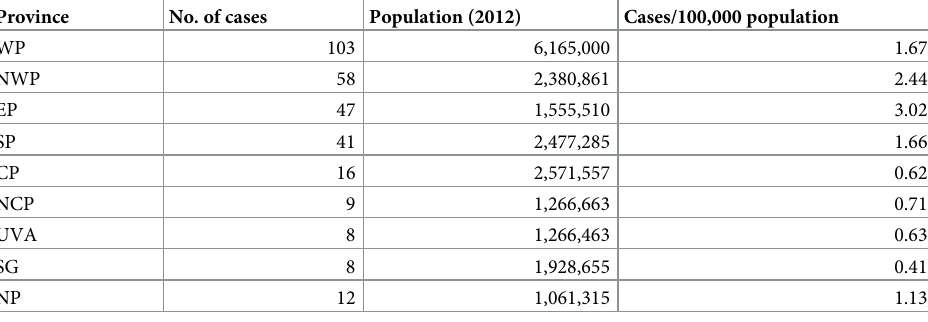
Distribution of epidemiology markers YLF/BTFC, bimA , fhaB3 and LPSA Genotyping of clinical isolates (n = 310) showed that the majority of Sri Lankan isolates belong to the YLF group (85.5%, n = 265). However, about 14.5% (n = 45) of BTFC positive isolates was found. Further, this study examined the regional distribution of YLF/BTFC gene clusters within the country (Fig 3A and S2 Table). It was noted that the relative frequency of the BTFC group was found to vary among regional populations. Sri Lanka is administratively divided into 9 provinces and, while isolates with YLF gene cluster were seen in all provinces, isolates Table 1. Culture positive melioidosis cases per 100,000 population for each of the nine